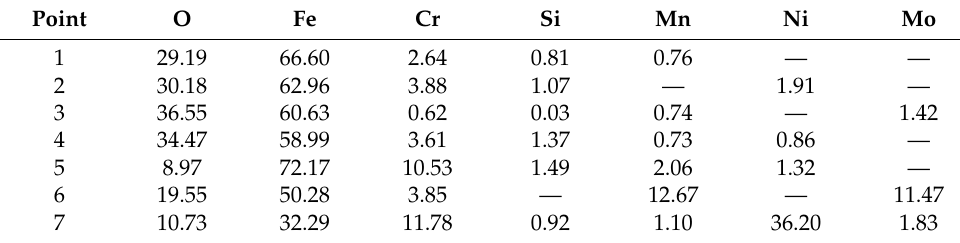
Figure 11. Surface morphologies and EPMA analysis of worn debris for A1 and A4 samples: ( a ) A1, ( b ) A4. Table 3. Element distribution at each point detected by EPMA in Figure 11 (wt.%).